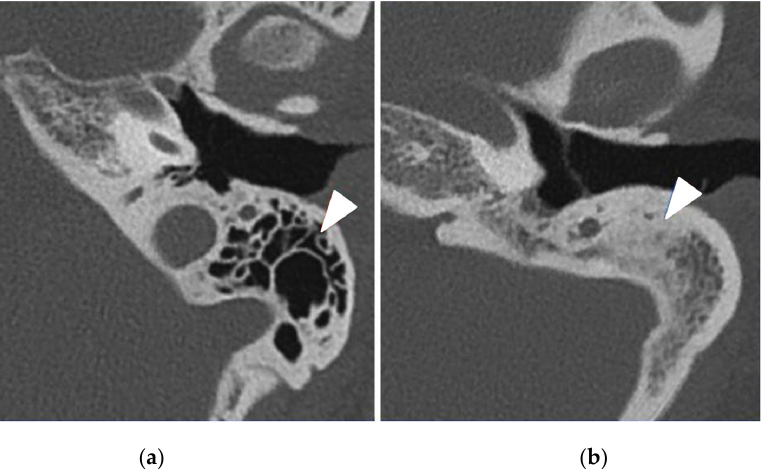
Figure 3. Left temporal bone CT scans in axial view showing (white arrowheads) ( a ) normal mastoid air cells (control patient) and ( b ) an important mastoid condensation (PCD patient).